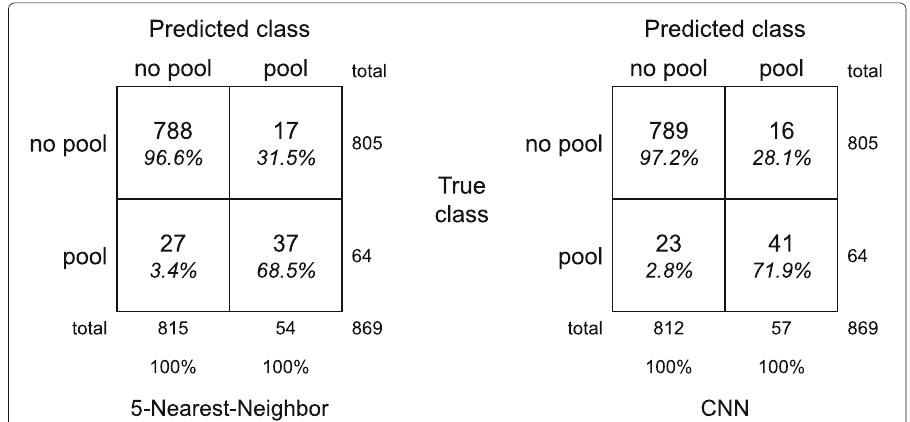
Fig. 4 left: Confusion matrix for the 5-nearest-neighbor classification with manual feature engineering from (Burkhart et al. 2018). The overall performance of the pool detection algorithm is 68.5% in terms of precision. The overall accuracy is 94.8%. right: Confusion matrix for the CNN classification: The overall performance is 71.9% in terms of precision. The overall accuracy is